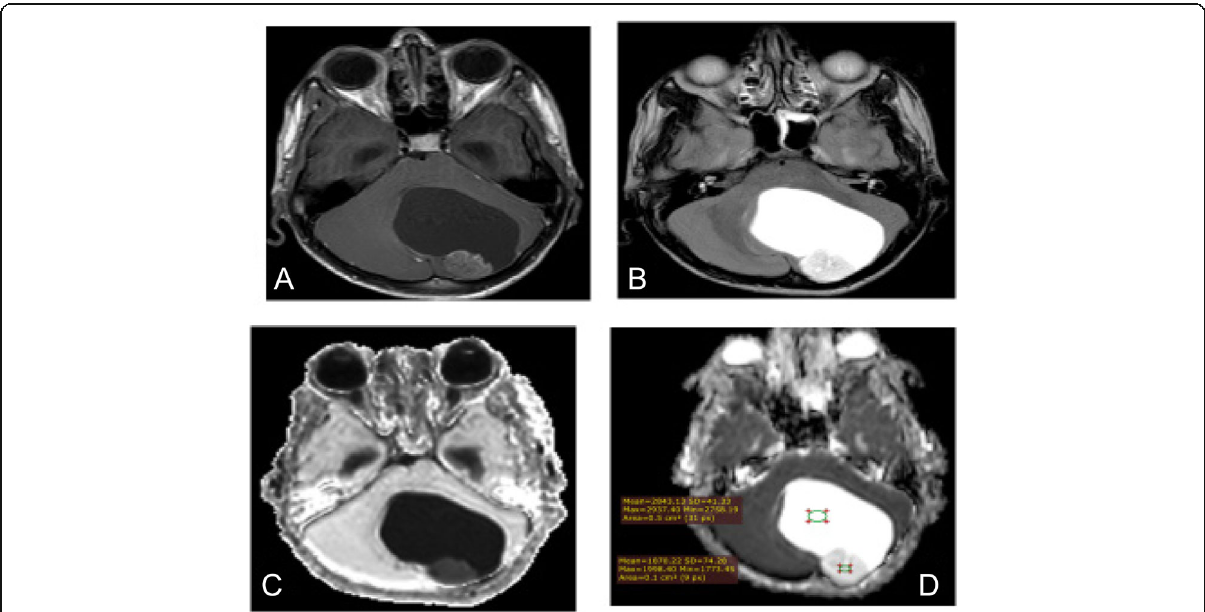
Fig. 2 Juvenile pilocytic astrocytoma in a 9-year-old boy who presented with repeated headache and vomiting. a T1-weighted (T1WI) shows intra-axial cystic space-occupying lesion (SOL) in the left cerebellar hemisphere. b T2-weighted (T2WI) showing hyperintense cystic posterior fossa mass with isointense solid mural nodule attached to the inner side of the cystic mass. Note the cystic components and relatively solid components. c Post-contrast T1WI axial image showing mildly enhancing solid components and faint enhanced cystic wall. d Apparent diffusion coefficient (ADC) map: the cystic component is bright while the solid component is relatively lower than the cystic component with